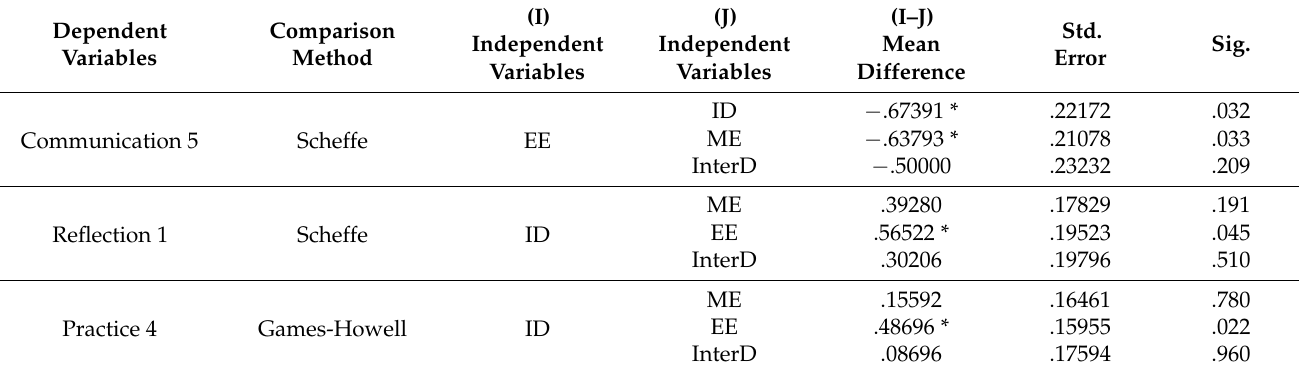
Table 6. Results of the Post Hoc Tests: Multiple